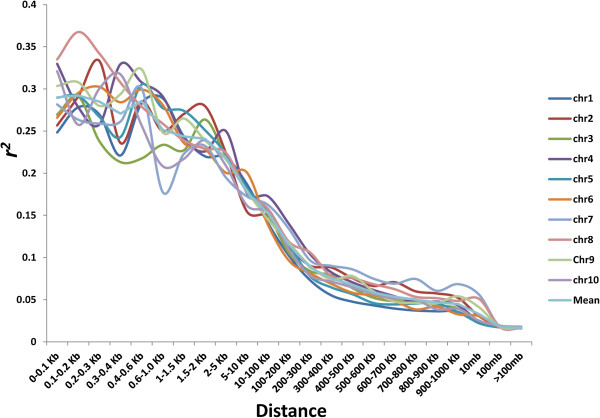
Linkage disequilibrium (LD) decay pattern of SNPs in all chromosomes. The mean r2 value was measured across 240 genotypes using SNPs with a MAF of ≥ 0.05. LD decay was considered at both the r2 ≤ 0.1 and r2 ≤ 0.2 levels.